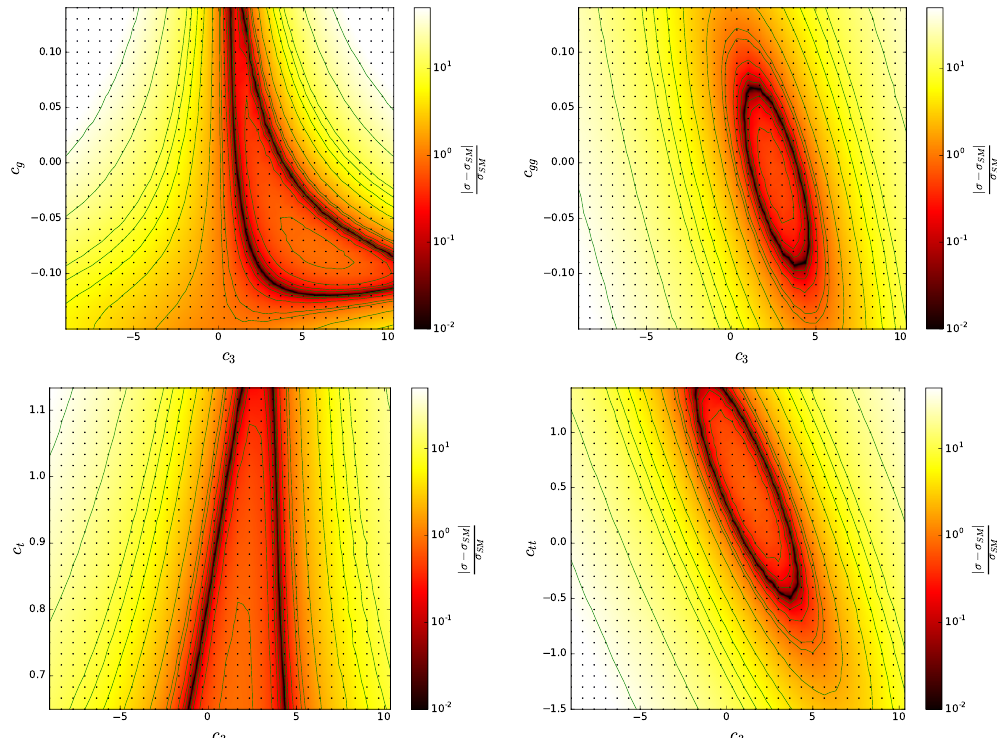
Figure 3 . Heatmaps showing the total cross section in a coloured logarithmic scale as a function of pairs of anomalous couplings. The degenerate directions are drawn in green lines, in particular the black region of the heatmaps shows some combination of parameters degenerate with the SM. The points mark the grid in which the cross section was computed, and a cubic interpolation was done elsewhere for illustrative